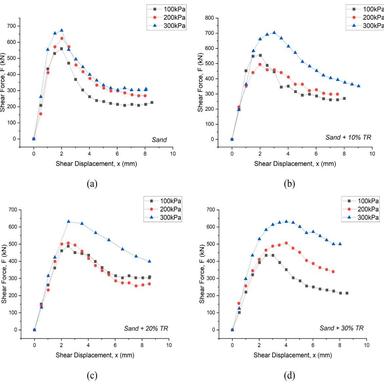
Shear Force-Shear displacement curve for sand and sand-tyre mixes, (a) Sand (b) Sand + 10 % TR (c) Sand + 20 % TR (d) Sand + 30 % TR.